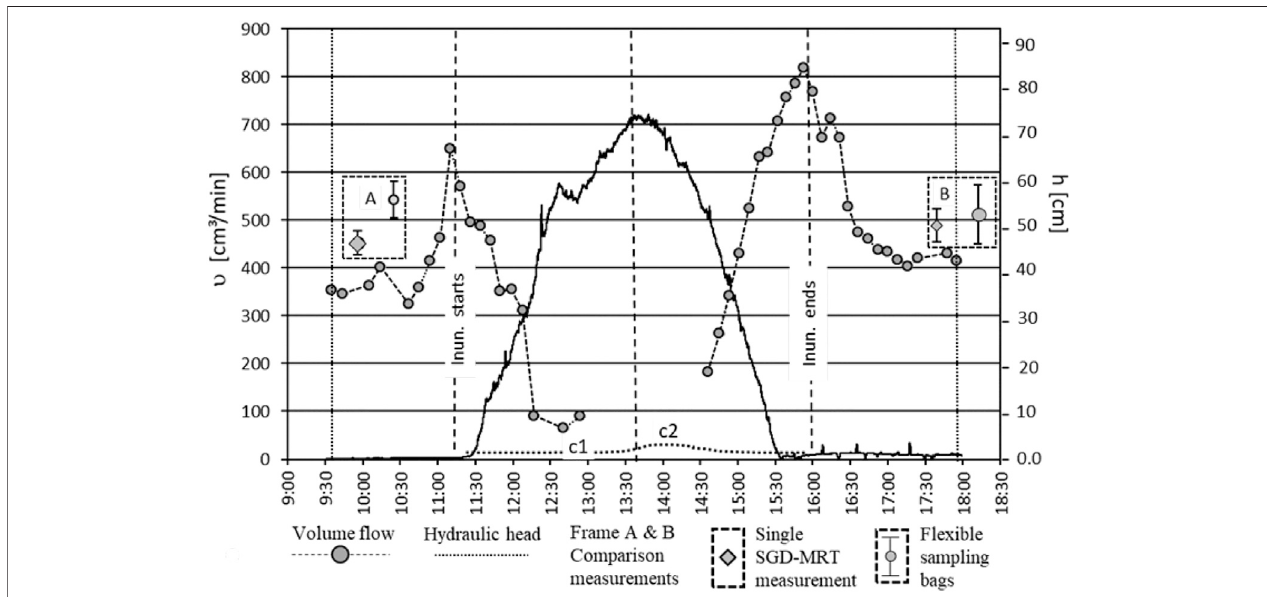
FIGURE 9| Time seriesdata ( Sahl#2 ) of fl uid discharge rates(cm³/min), and the hydraulic head (cm) measured by the SGD-MRT and the salinity inside the benthic chamber (c1: 2.9 mS/cm, c2: 5.2 mS/cm) recorded by a CDT diver. In data frames A and B, discharge rates measured with the SGD-MRT and fl exible sampling bags compareconventionalLee-typeseepagemetermeasurementsindicatedbyagreycirclewithanerrorbar.Theperiodoftheinundationofthedischargesiteismarkedby inun.starts and inun.ends.